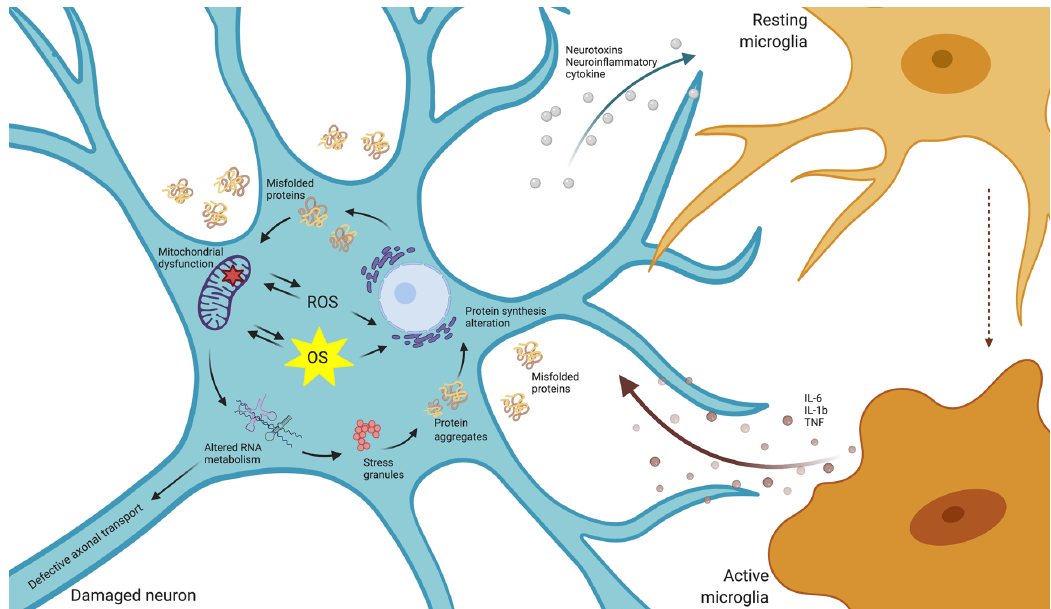
Figure 1. Oxidative stress in neurodegenerative disorders. Dysfunction in neural protein synthesis and processing entails mitochondrial defects, the alteration of RNA metabolism and the deposition of protein aggregates, which ultimately, encompass the generation of ROS and OS. At the same time, ROS neuroimmune cells and enhances the production of neuroinflammatory